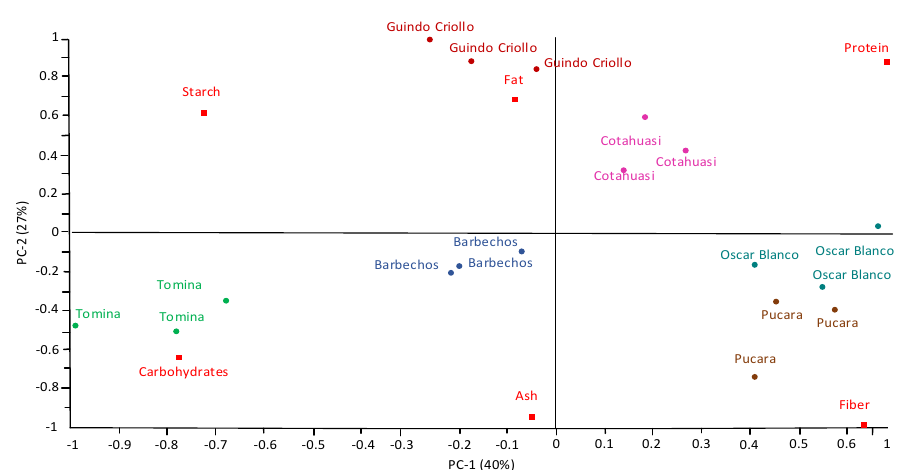
FiberCarbohydrates